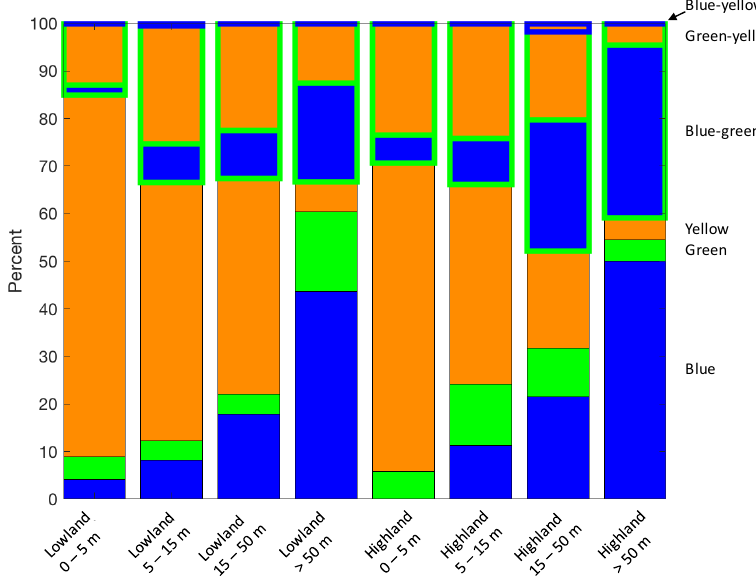
Figure 13. Percentage distribution of lakes in colour bins according to Table 1 in elevation-depth classes [29]. Lowland and highland lakes are where the lake surface is below 300 m and above 300 m, respectively.